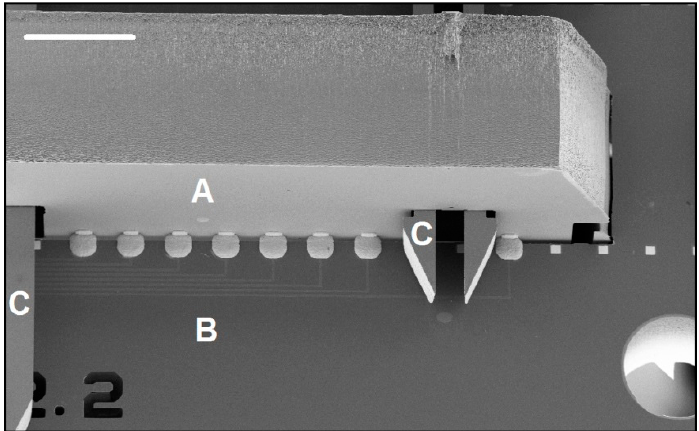
Figure 8. SEM image of an earlier electrolytic plating design, showing 2-D insert (A), holder plate (B) and self-locking hook (C). The scale bar is 400 µm.